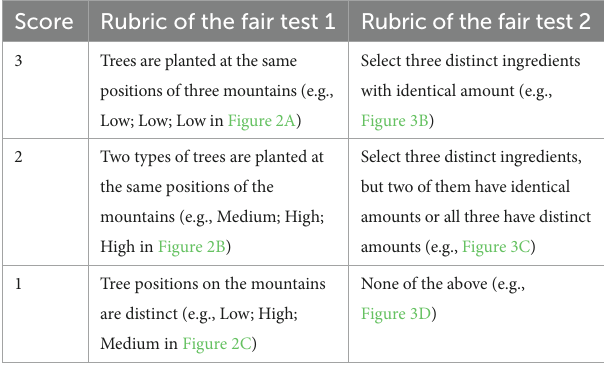
TABLE 2 Scoring rubrics of the fair tests 1 and 2. Score Rubric of the fair test 1 Rubric of the fair test 2 3 Trees are planted at the same positions of three mountains